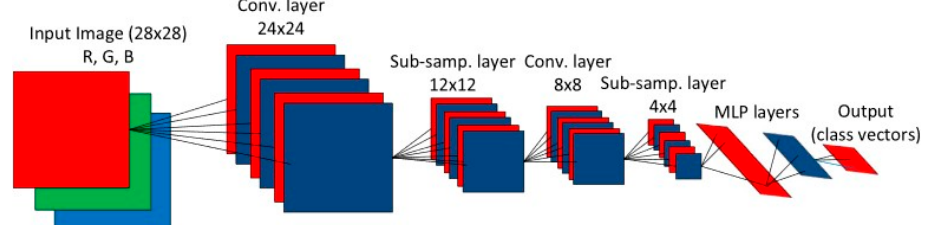
Figure 2. Overview of a conventional 2D convolutional neural networks (CNN) Ince et al. [24] with permission from IEEE.